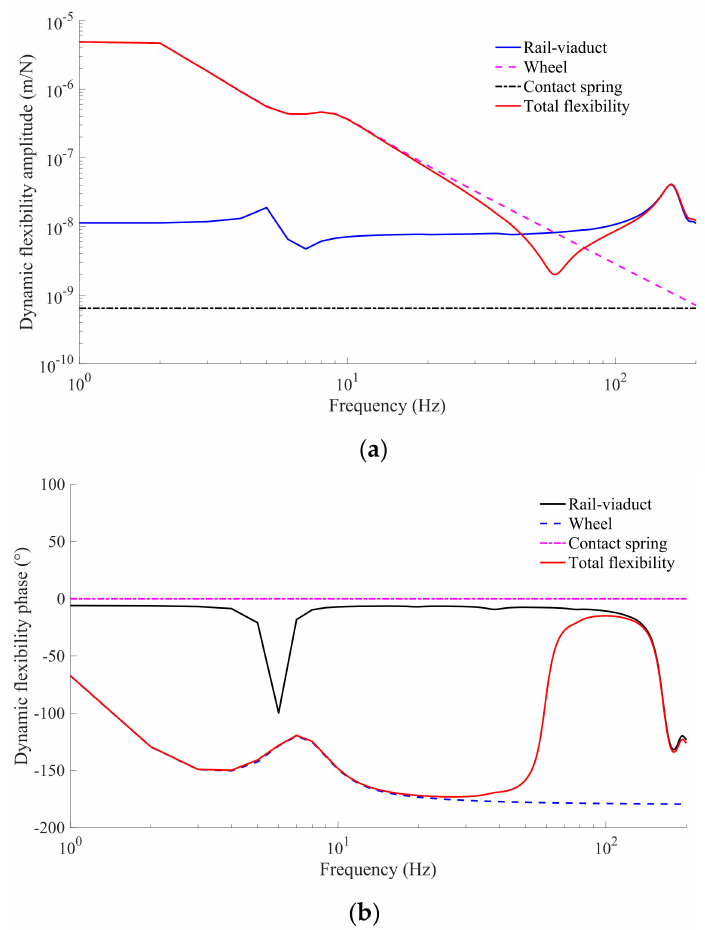
Figure 3. Dynamic Flexibility Amplitude and Phase of Vehicle-Track-Bridge System; ( a ) The dynamic flexibility amplitude; ( b ) The dynamic flexibility